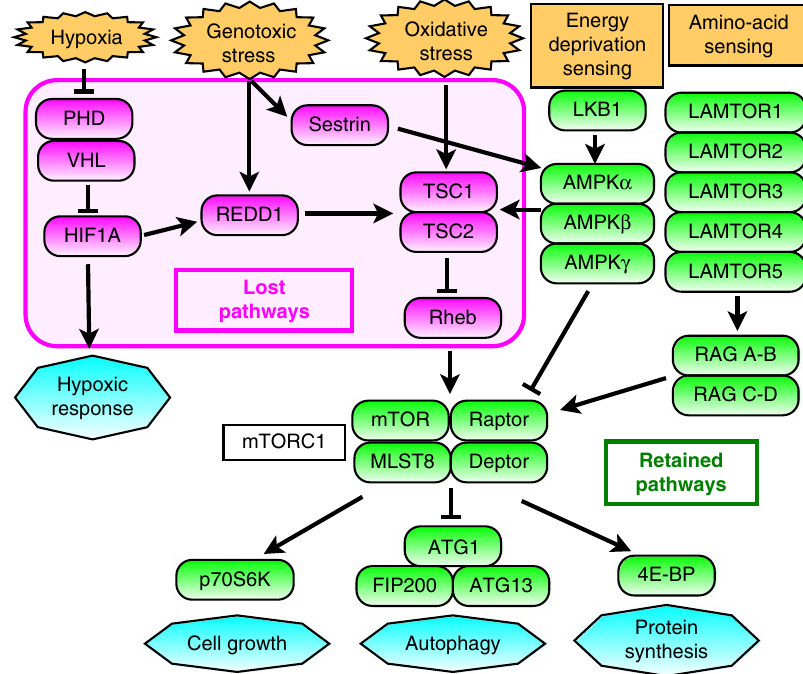
Figure 2 | Selective loss of stress responsive signalling to mTORC1 downregulation. Gene networks involved in the regulation of mTORC1 activity. Magenta indicates genes absent in the tardigrade genome and green indicates retained genes. The interconnected eight genes mediating environmental stress stimuli to downregulate mTORC1 were selectively lost, whereas all components involved in sensing and mediating physiologic demands were